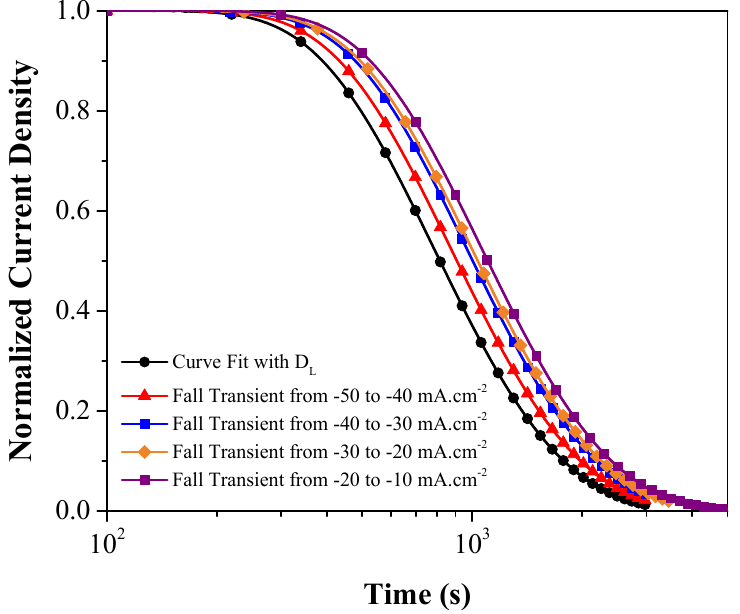
Figure 10. The schematic normalized current density for the decay transient for each fall transient and the theoretical curve calculated using D L = 1.58 × 10 −10 m 2 ·s −1 for DP1000 steel.